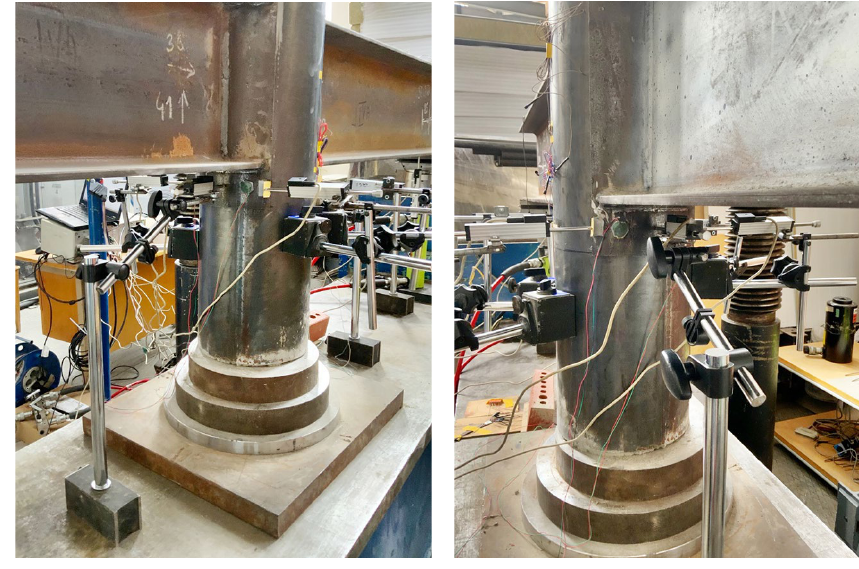
Figure 11. Placement of LVDTs in the tension zone of the joint bolts)a)